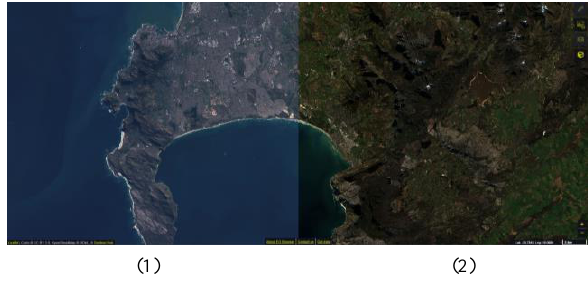
Figure 2: (1) L1C and (2) L2A processed data as viewed in EO Browser.